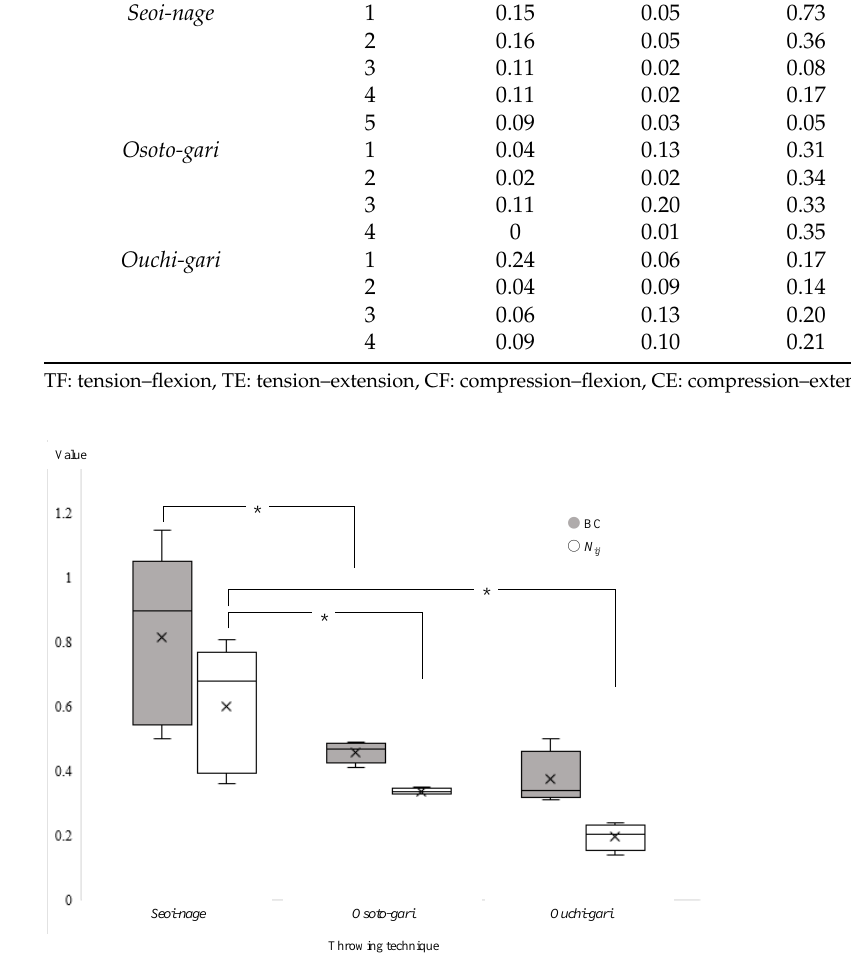
Table 1. Results of the neck injury criterion N ij by throwing techniques.